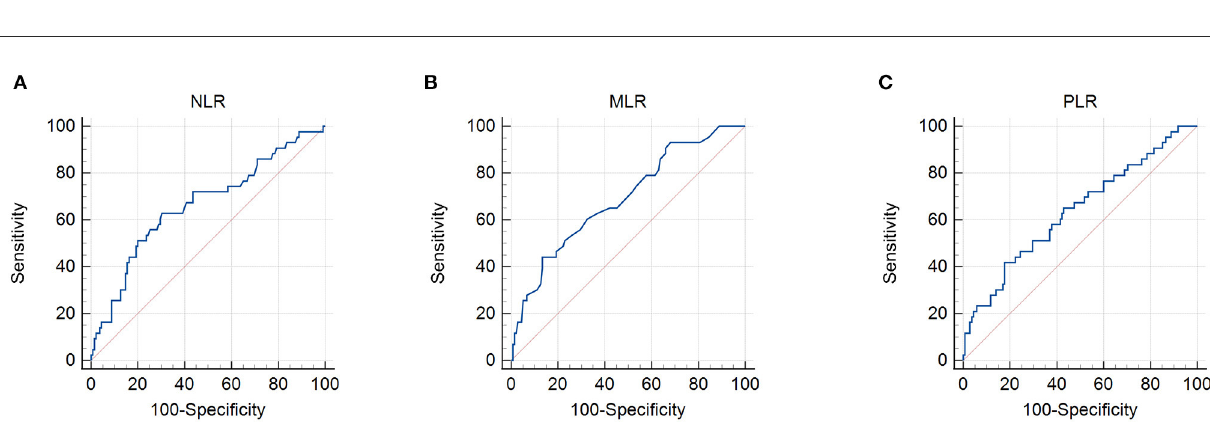
FIGURE2 Receiver operating characteristic curves for the use of inflammatory indicators to predict life expectancy in patients with stage IIB–III cervical cancer receiving radiotherapy based on: (A) neutrophil/lymphocyte ratio (NLR), (B) monocyte/lymphocyte ratio (MLR), and (C) platelet/lymphocyte ratio (PLR). Cut-off points with the highest combined sensitivity and specificity were